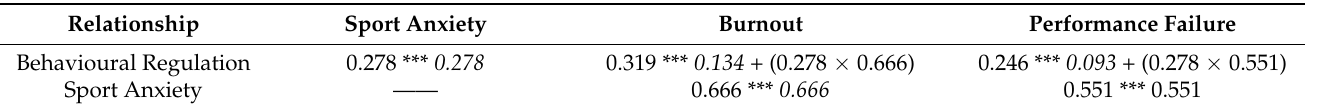
Table 6. Total effects between constructs.